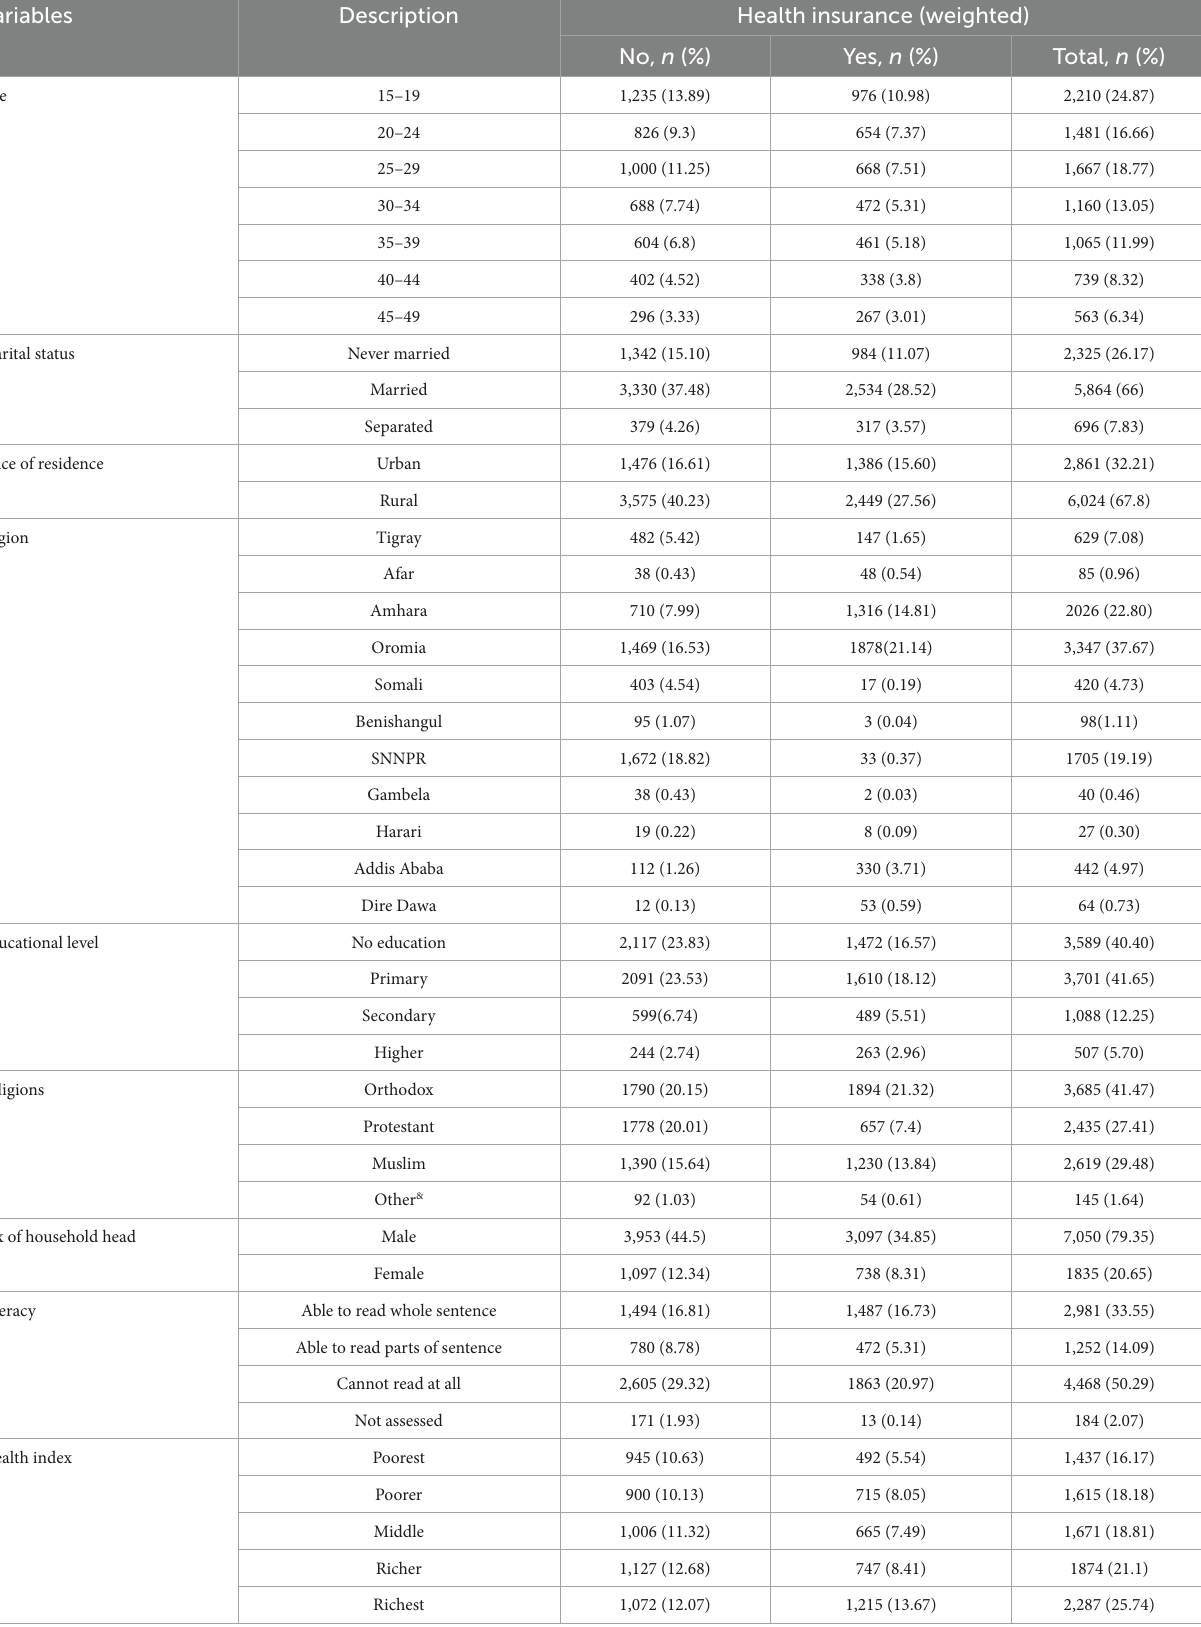
TABLE 1 Sociodemographic characteristics of reproductive age women in Ethiopia, 2019 ( n = 8885).